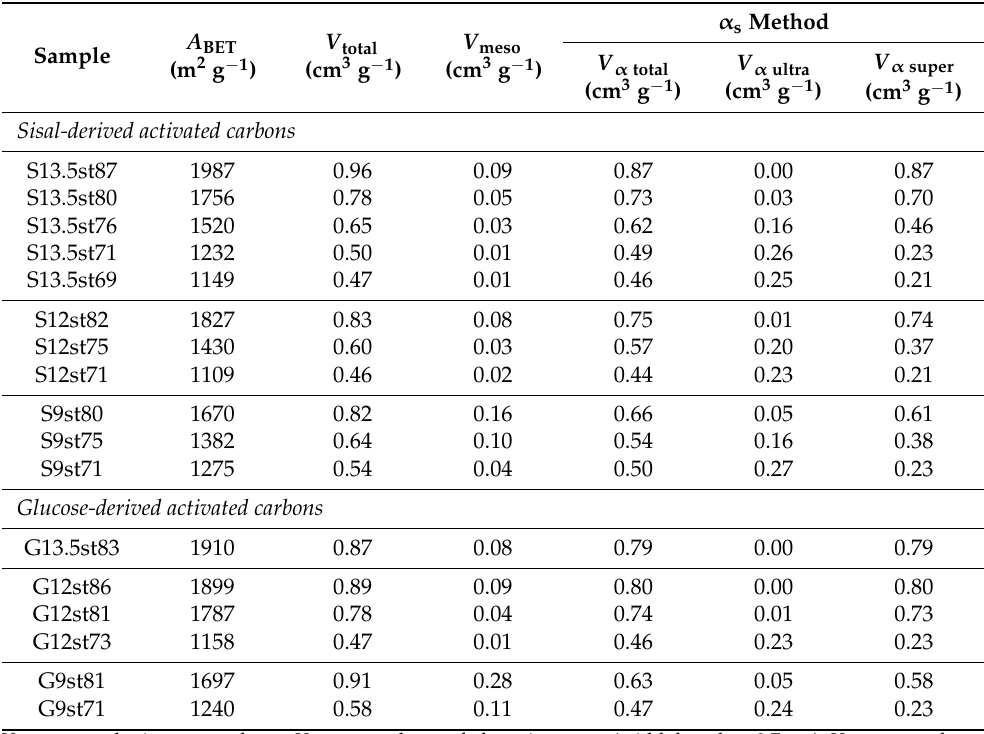
Table 2. Textural properties of the activated carbon materials.